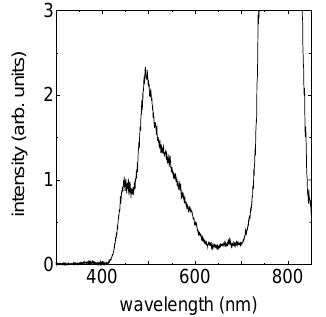
Figure 1. Visible broadband spectrum generated by self-phase modulation of the NIR pulse. The very intense signal in the 800-nm region is due to the fundamental of the Ti:sapphire laser. To use the WLC as a seed pulse in the NOPA, its temporal duration should be compressed to be equal to or slightly shorter than that of the pump SHG pulse for the NOPA for efficient amplification. Generation of the WLC (in the sapphire plate) results in a temporally stretched pulse, so a pair of chirped mirrors is employed for pulse compression. In addition, the NOPA pump pulse is stretched to better match the pulse duration of the seed, as described below.